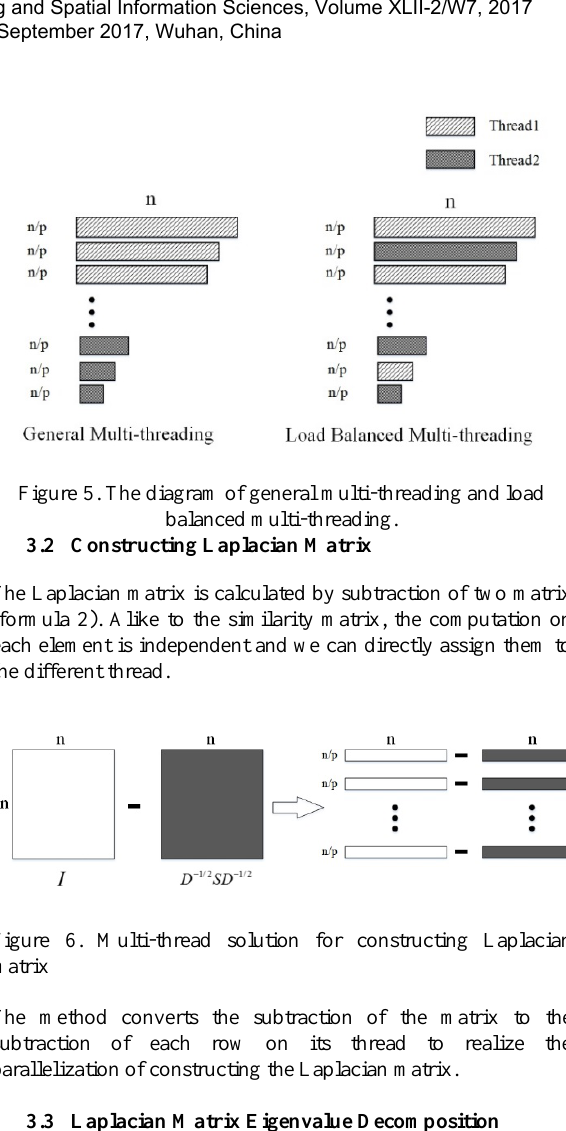
Figure 4. Multi-thread solution for constructing similarity matrix